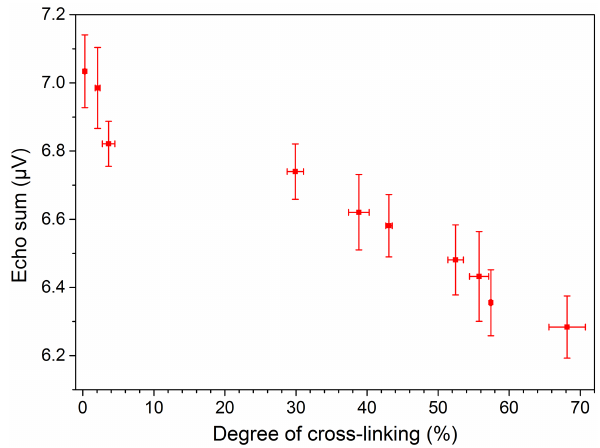
Figure 7. Echo sum vs. degree of cross-linking of PE-Xc using the CPMG pulse sequence.